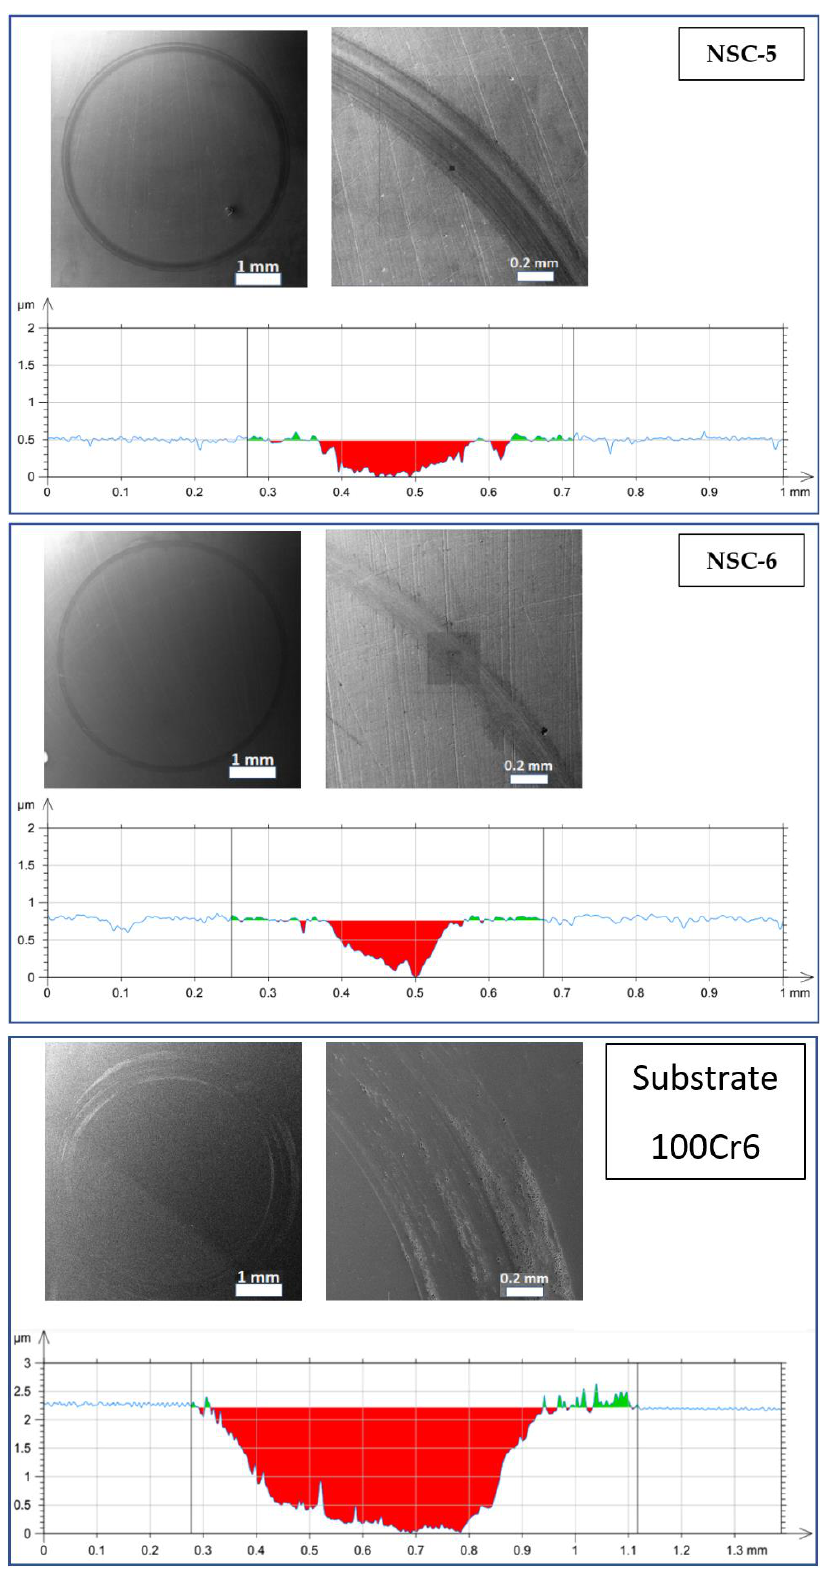
Figure A1. Wear track SEM images and cross-sectional profiles for NSC coatings and substrate 100Cr6. Top left: wear track SEM overview, Top right: wear track SEM closeup, Bottom: wear track cross-sectional profile.